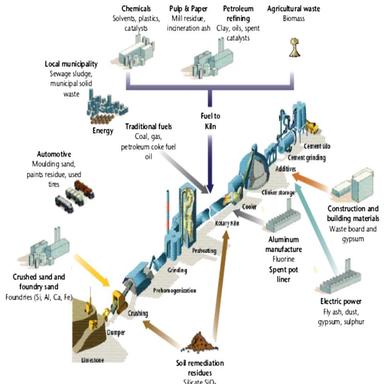
Examples of feeding alternative raw materials (Secretariat of the Stockholm convention 2007).